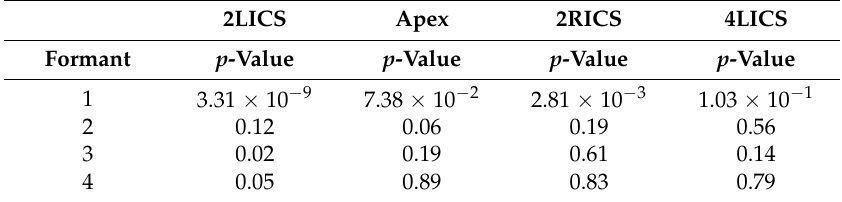
Table 2. Formant Selection. A two-sample independent t -test was performed and a significant difference was detected between subjects with a normal pulmonary artery pressure and those with pulmonary artery hypertension. It is clear that the first formant is more informative than other three formants as it scored the lowest p -value among all of them. Moreover, the 2LICS is more informative compared to the other three recording sites. Abbreviations: 2LICS = 2 nd left intercostal space, 2RICS = 2 nd right intercostal space, and 4LICS = 4 th left intercostal